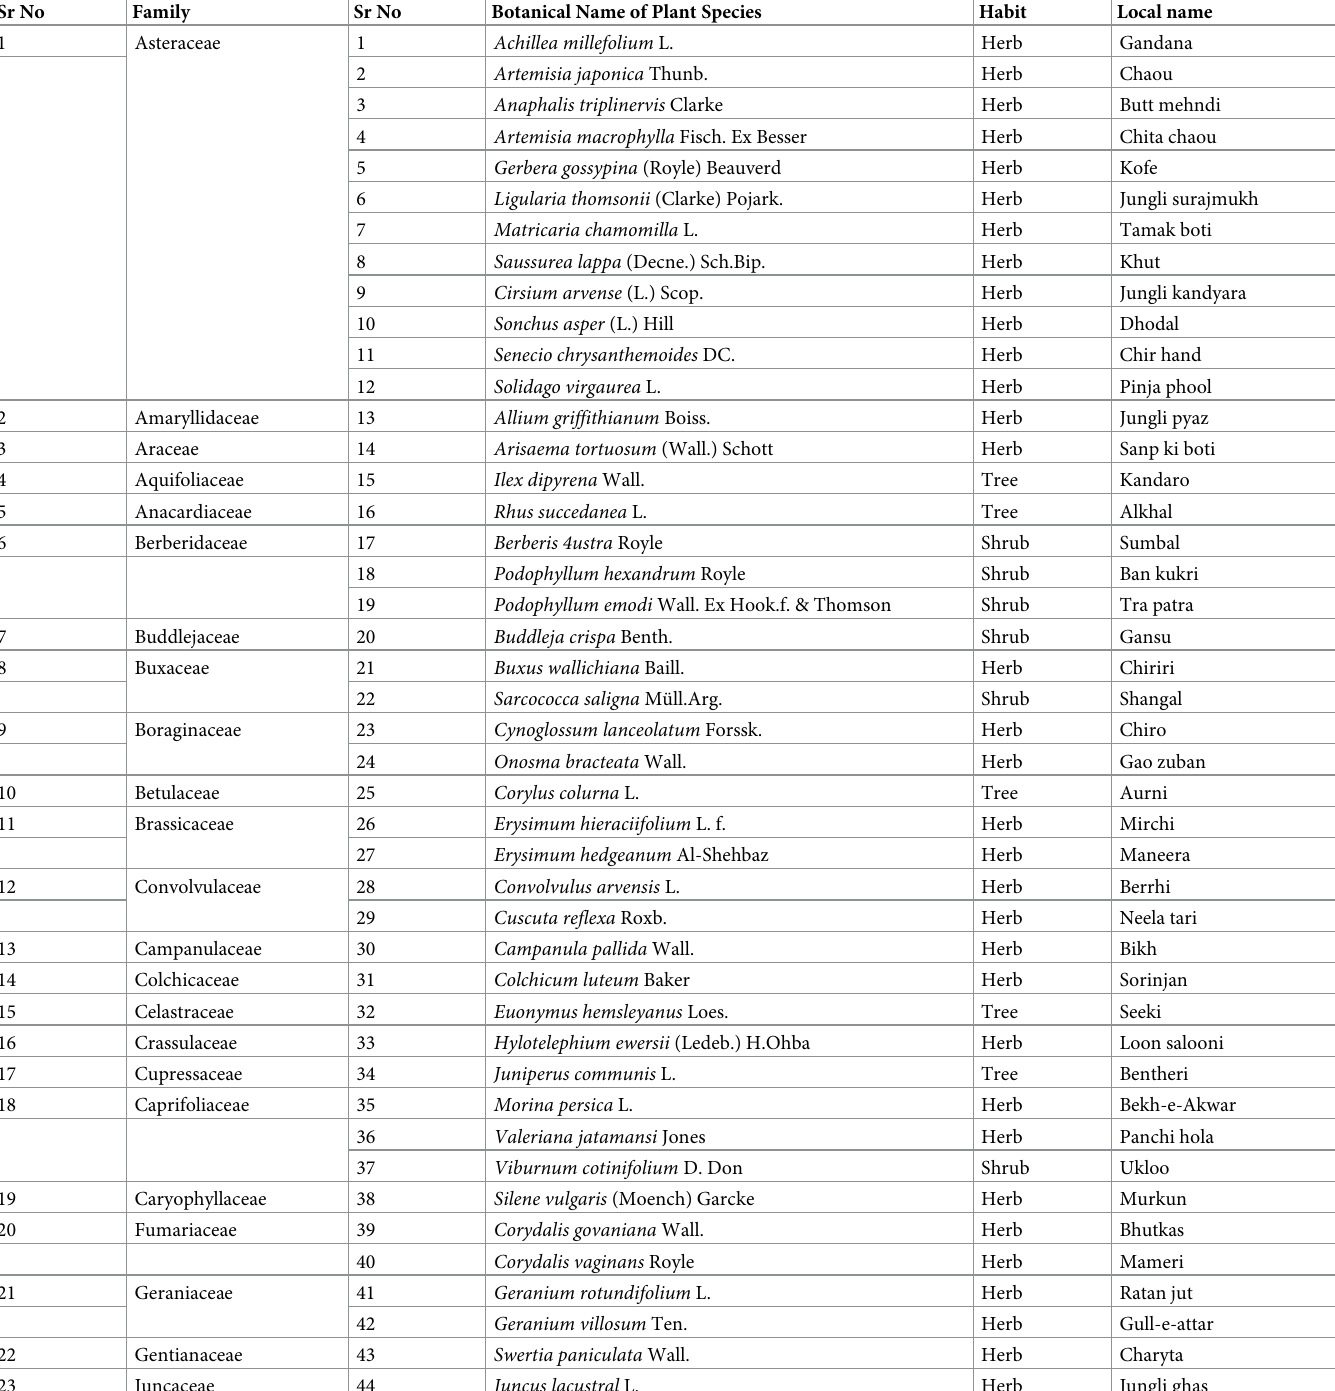
Table 3. Familywise Inventory of wild indigenous plants of Dawarian to Ratti Gali, District Neelam of Azad Jammu and Kashmir, Pakistan (note: Herbarium voucher numbers are cited in Table 4). Sr No